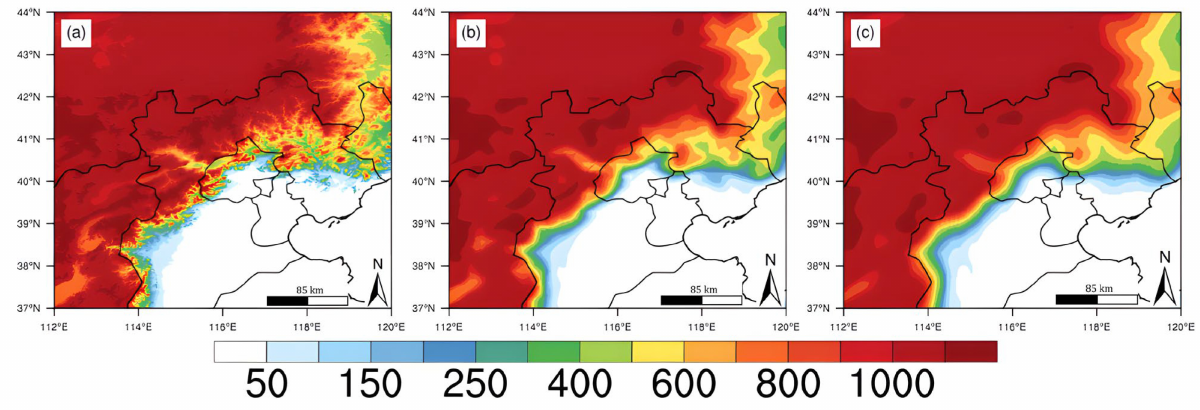
Figure 12. Orographic height (unit: m): ( a ) the new initial orography before processing, ( b ) new orogra- phy processed using the bidirectional one-dimensional filter, and ( c ) the model’s original